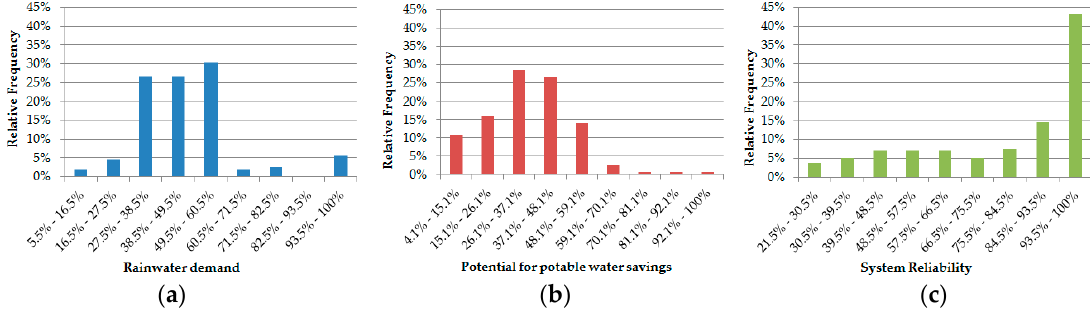
Figure 3. Histograms of ( a ) rainwater demand, ( b ) potential for potable water savings, and ( c ) system